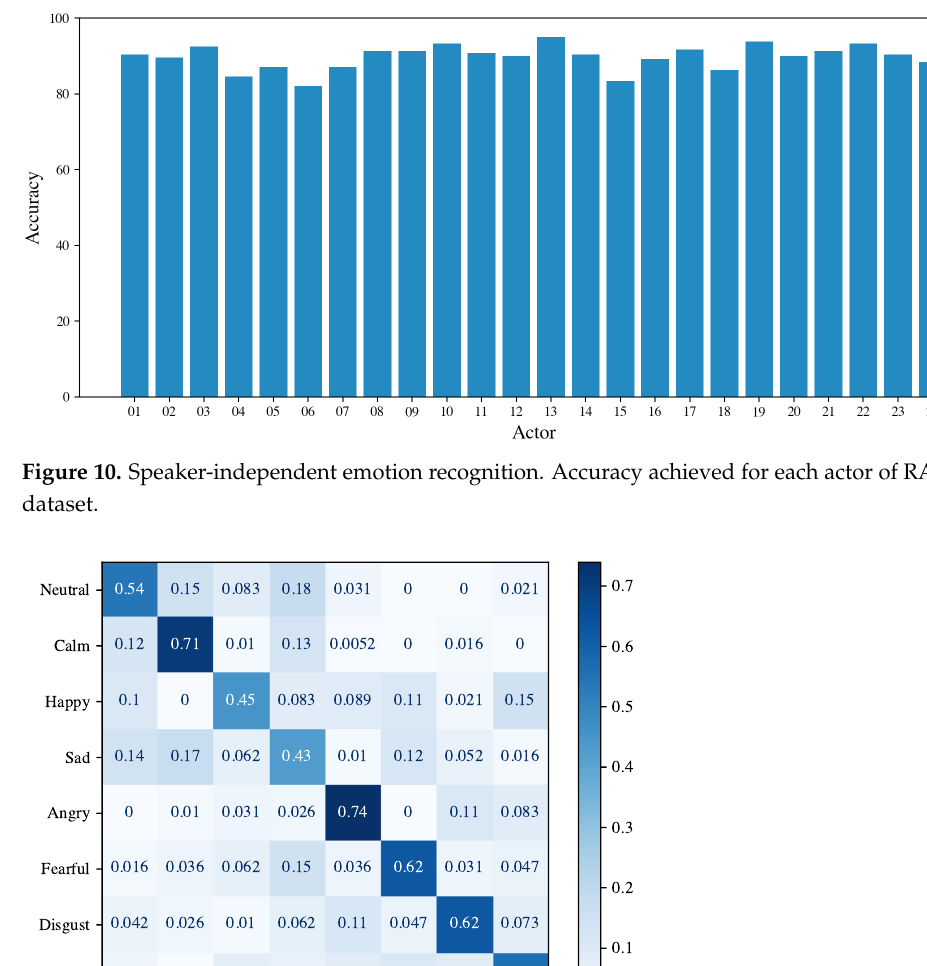
Figure 9. Confusion matrix for speaker-dependent emotion recognition.